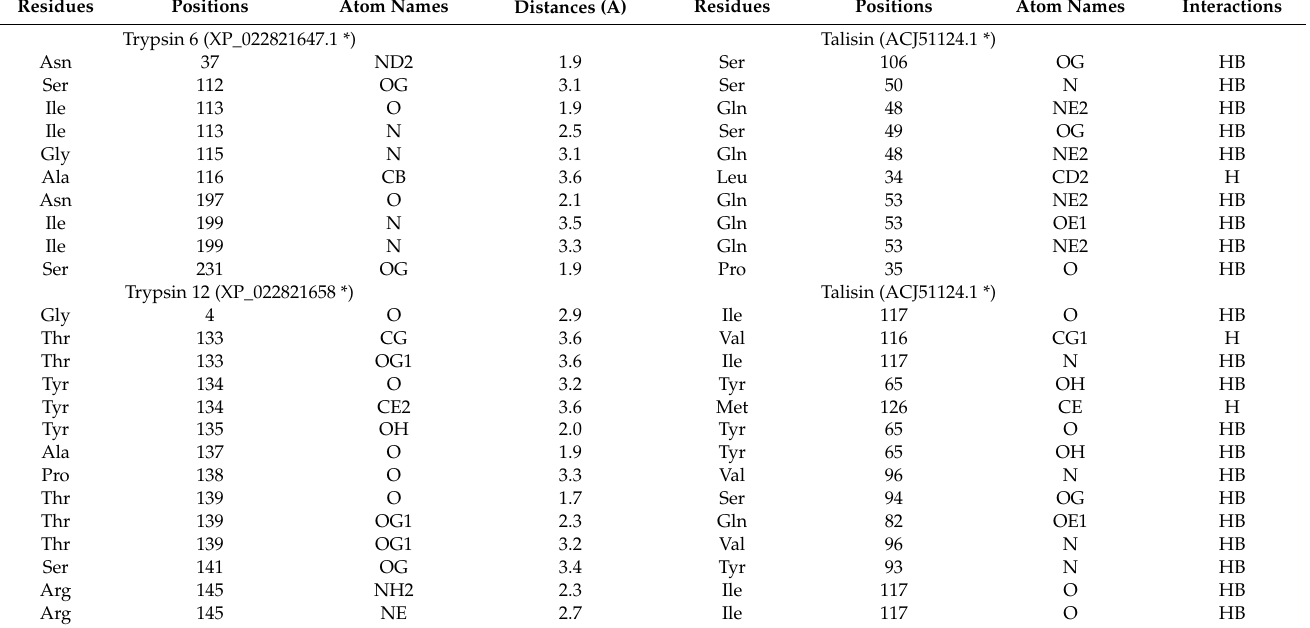
Table 4. In silico interactions for the complexes talisin / Trypsin 6 ( − 8.4 kcal · mol − 1 ) and talisin / Trypsin 12 ( − 8.8 kcal · mol − 1 ).